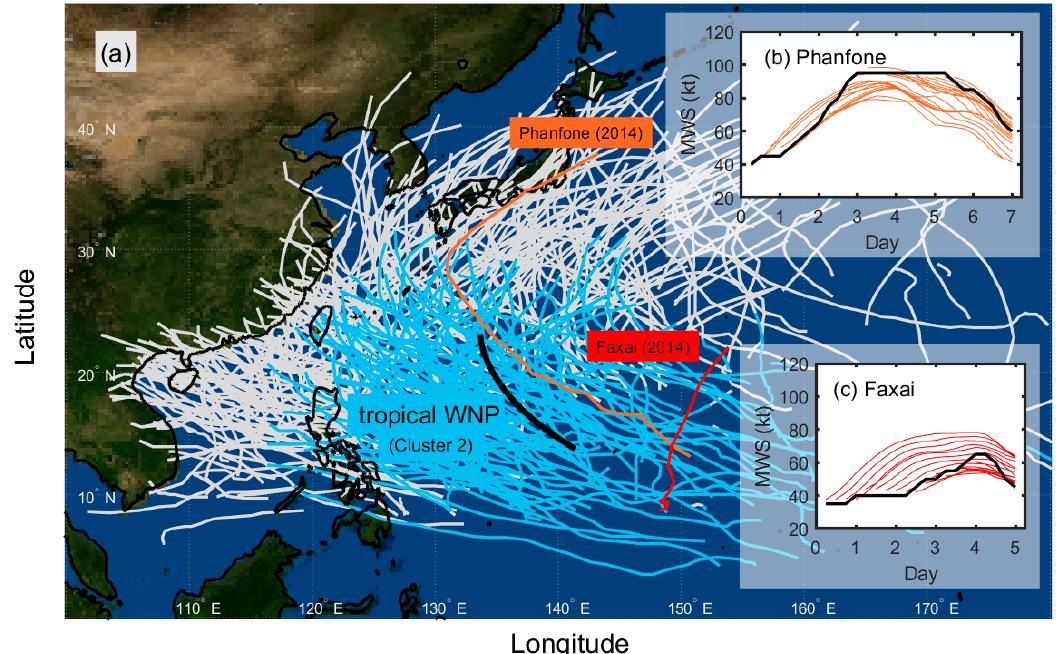
Figure 1. ( a ) All tracks in the tropical western North Pacific (Cluster 2, blue lines), and all tracks in the western North Pacific (gray lines) in 2004–2014. The orange and red lines indicate the tracks of Typhoon Phanfone and Faxai in 2014, respectively. The thick black line is the mean track for Cluster 2 in CSTIPS-DAT. Results of individual intensity predictions from CSTIPS-DAT for Typhoons ( b ) Phanfone and ( c ) Faxai in 2014. A thick black line is an observation (Regional Specialized Meteorological Center best track data), and the colored lines are individual CSTIPS-DAT predictions.